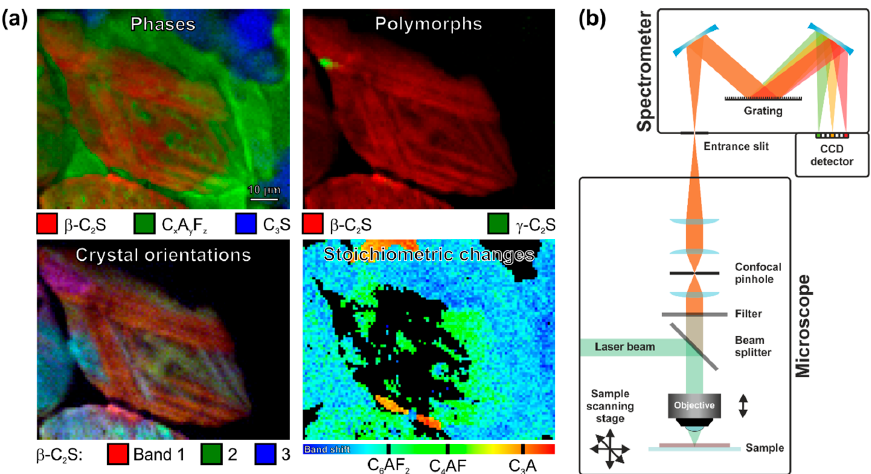
Figure 1. ( a ) Summary of chemical and physical properties of minerals that can be derived from Raman spectra using a 19th century cement mortar as an example. ( b ) Schematic of a Raman microscope with a dispersive spectrograph (figures are adapted from [1]; see reference for details). CCD, charge coupled device.